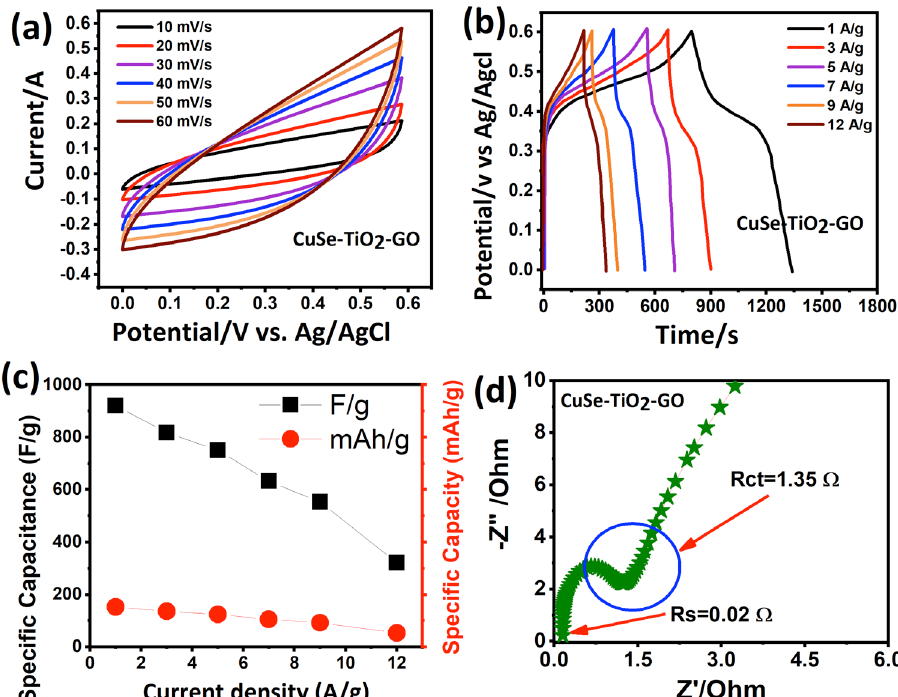
Figure 5. The CuSe-TiO 2 -GO nanocomposite and its capacitive performance analysis, ( a ) CV profile, ( b ) discharge/charge platforms, ( c ) variation in capacitance with current rates, ( d ) impedance plot. Table 1. The current discharge rates and the capacitance values of the CuSe-TiO 2 -GO nanocompo- site.